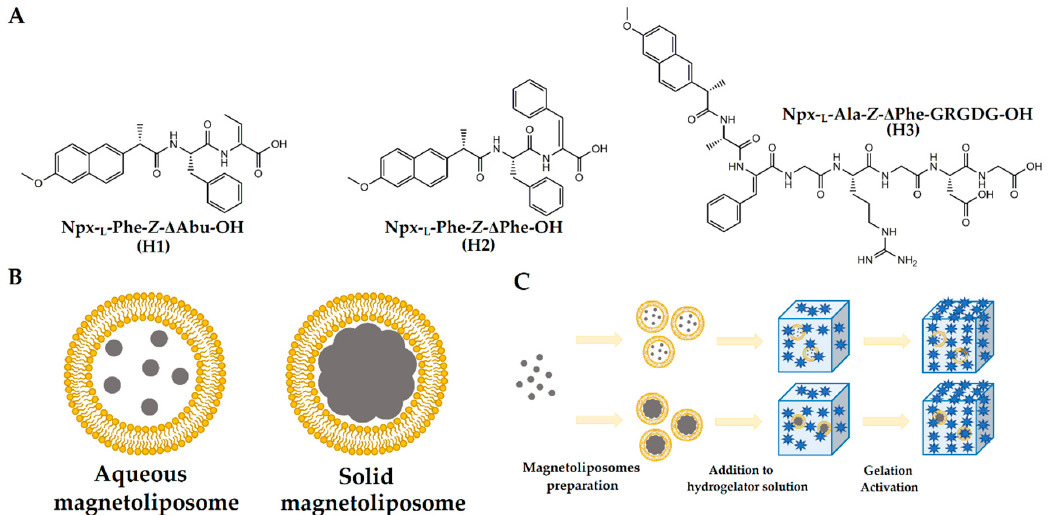
Figure 1. ( A ) Hydrogelator molecules used in this work. Legend: Npx: naproxen; Phe: phenylalanine; Ala: alanine; G: glycine; R: arginine; D: aspartate; Δ Abu: dehydroaminobutyric